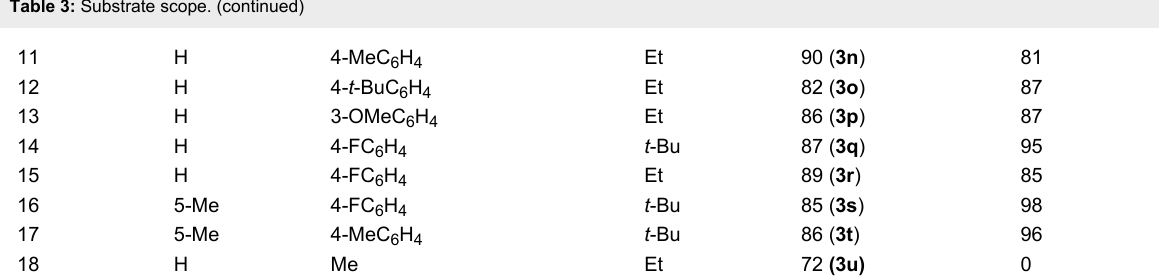
Table 3: Substrate scope. (continued)